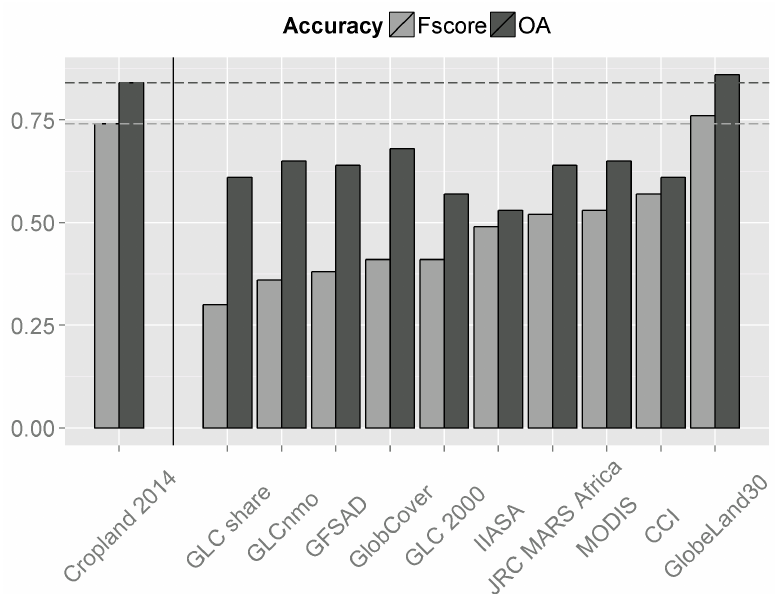
Figure 13. Comparison of the 2014 Sudano-Sahelian Cropland map with the ten previous global products showing high variability in the accuracy indices and better performance for the 2014 Sudano-Sahelian Cropland map and GlobeLand 30 used as the labeling